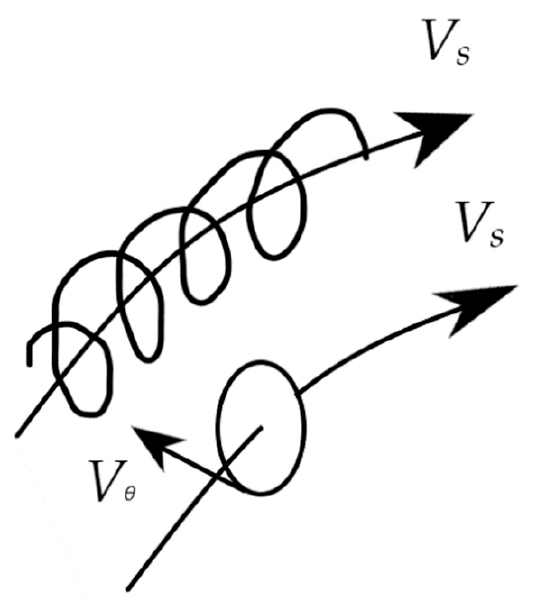
Figure 10. Scheme of secondary swirl. SVT was dissected in the meridian direction with a step of 5 degrees (Figure 11) to de- termine the degree of secondary swirl and the maximum decrease in the total temperature.